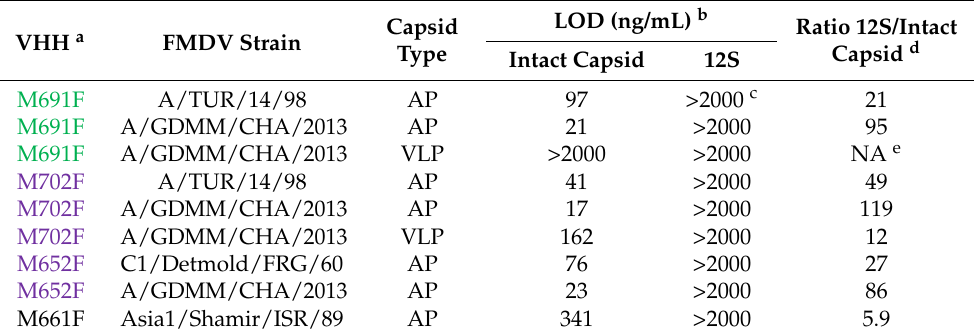
Table 3. The limit of detection (LOD) of VHH-based DAS-ELISAs. Various authentic particles (AP), VLPs, or their 12S particles prepared by heating were titrated in ELISA in triplicate. VHH a